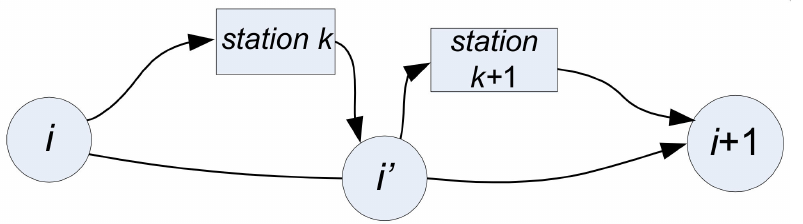
Figure 5. The solution. The hub i’ is inserted between the i -th and i + 1-th hub on the basis of the description of Case 2. Hub i’ becomes a mandatory